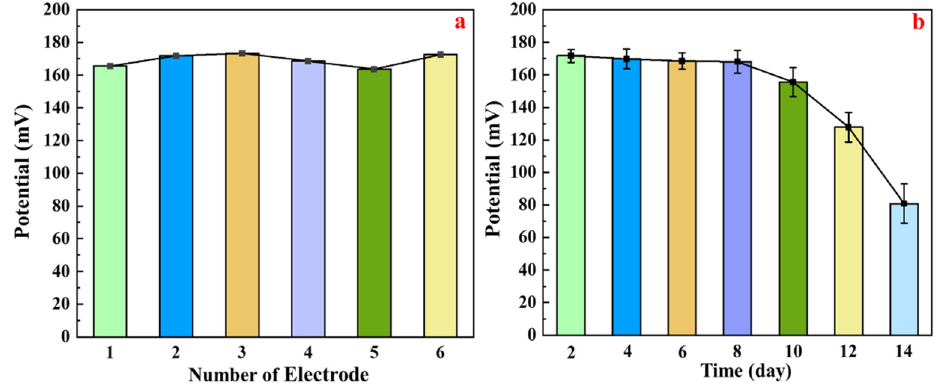
Figure 12. Performance comparison of different SC-NO 3 − -ISEs. Ref. [36,46–48] are compared with this research.